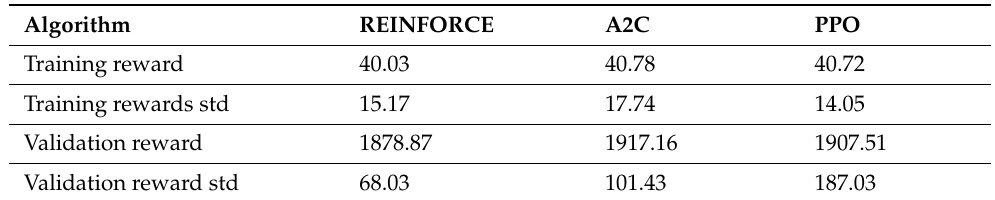
Table 6. Rewards and standard deviation at the last episode.